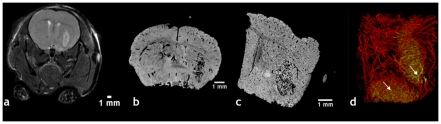
Multi-scale MRI of a 9L brain tumor model.(a) In vivo T2-weighted MRI at the ‘systemic’ scale (∼150 µm); ex vivo μMRI at two ‘intermediate’ scales: (b) ∼60 µm, and (c) ∼30 µm. (d) Ultra-high resolution vascular μMRI image in which vessels have been segmented into tumor vessels (gold) and normal vessels (red). One can clearly visualize the abnormal tumor vessel architecture and changes in vessel morphology at the tumor-host tissue interface (arrows).